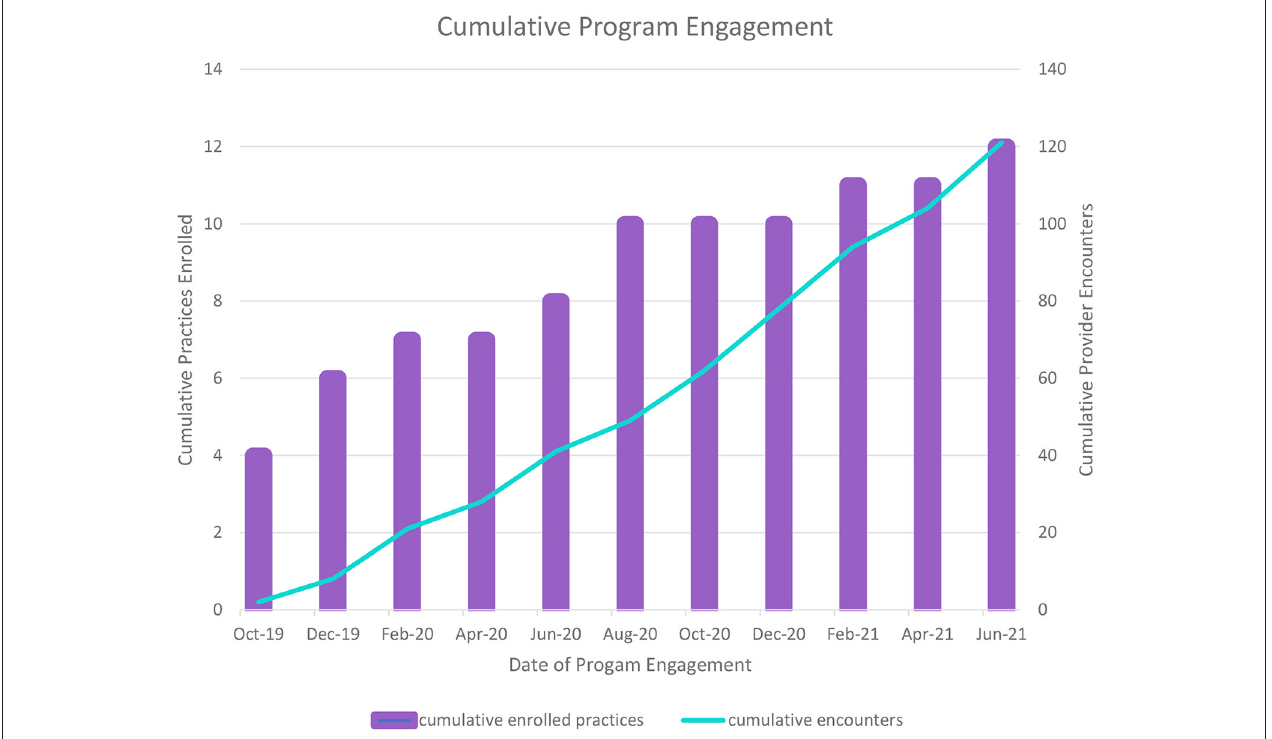
FIGURE 1 | Implementation of a multi-component behavioral health integration program in obstetrics for perinatal behavioral health.